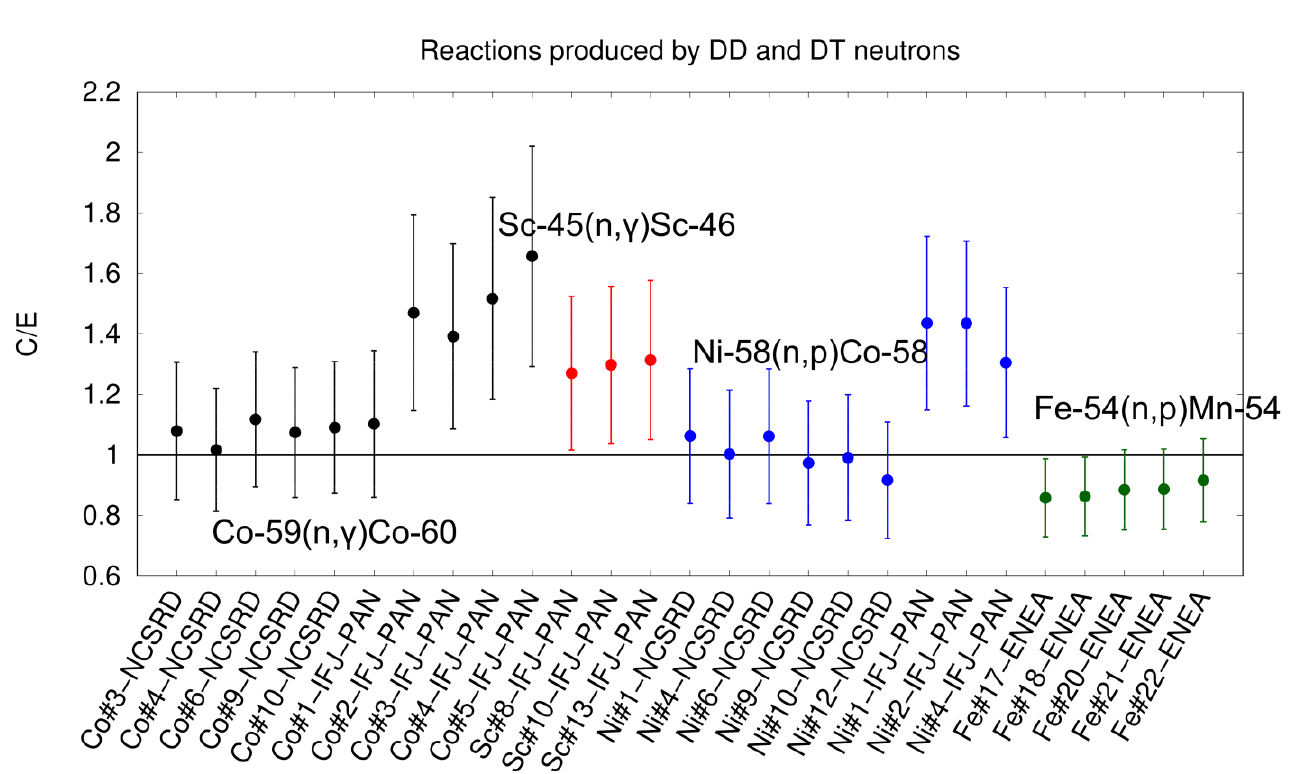
Fig. 8 Comparison of the calculated activity with measured isotopes in dosimetry foils produced by DD and DT neutrons - Co-59(n, γ )Co-60, Sc- 45(n, γ )Sc-46, Ni-58(n,p)Co-58 and Fe-54(n,p)Mn-54. The DT neutron fraction used in the analysis was 1.4 %. The error bars represent 2 sigma statistical uncertainty of MCNP calculations and uncertainty in measured sample activity. The number next to the material name represents the ID of the